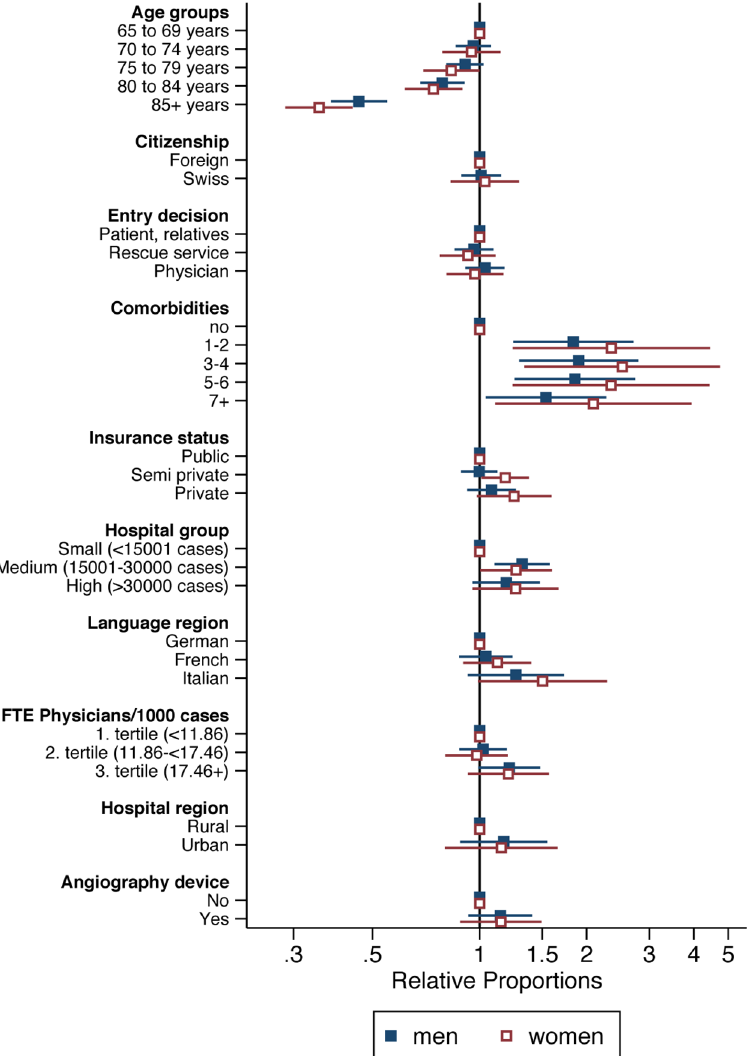
Fig 4. Results of multilevel Poisson regression for revascularization for male and female patients 65 years and